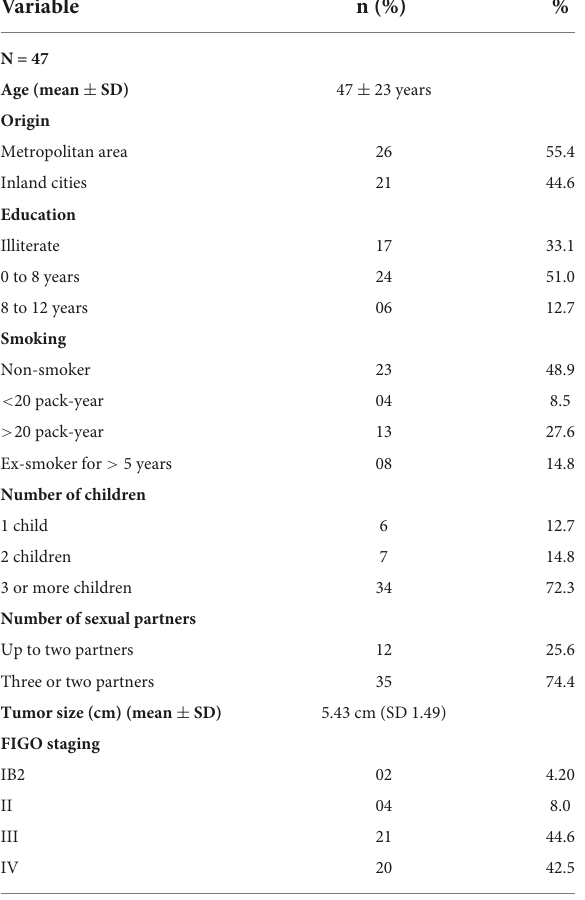
TABLE 1 Clinical and demographic characteristics of the study patients.